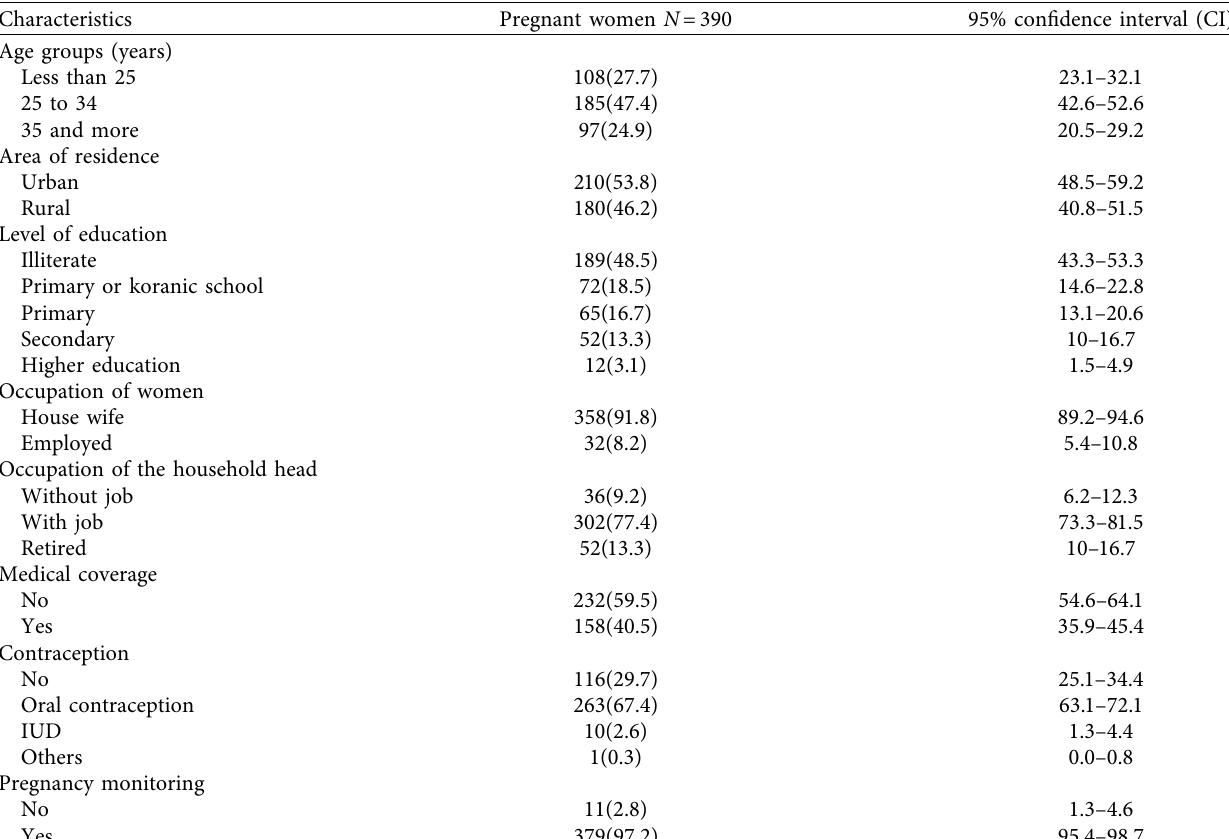
Table 1: Sociodemographic characteristics among pregnant